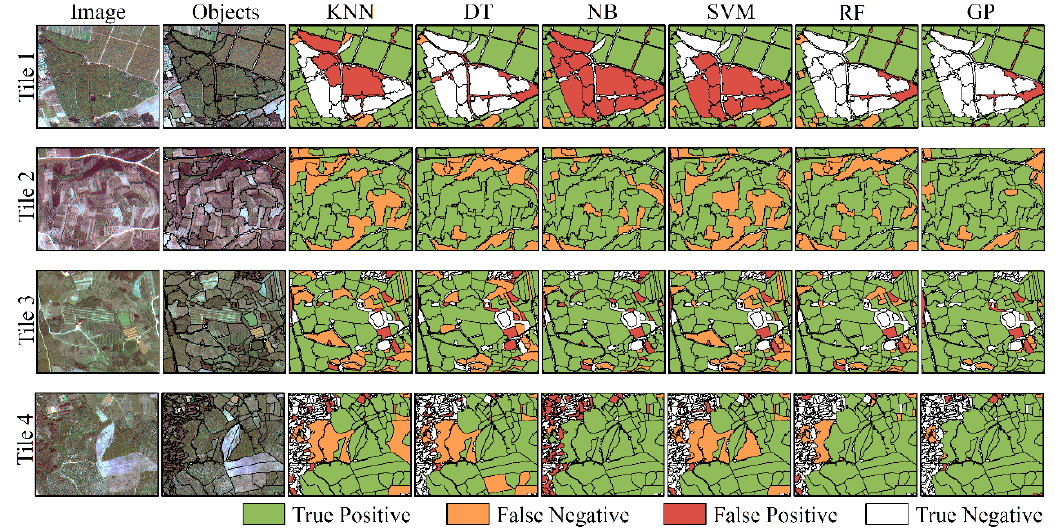
Figure 7. Classification results of six methods in four tiles, i.e., K-Nearest Neighbor (KNN), Decision Tree (DT), Naïve Bayes (NB), Support Vector Machine (SVM), Random Forest (RF) and GP. The effect of sample size on the performance of the six methods is shown in Figure